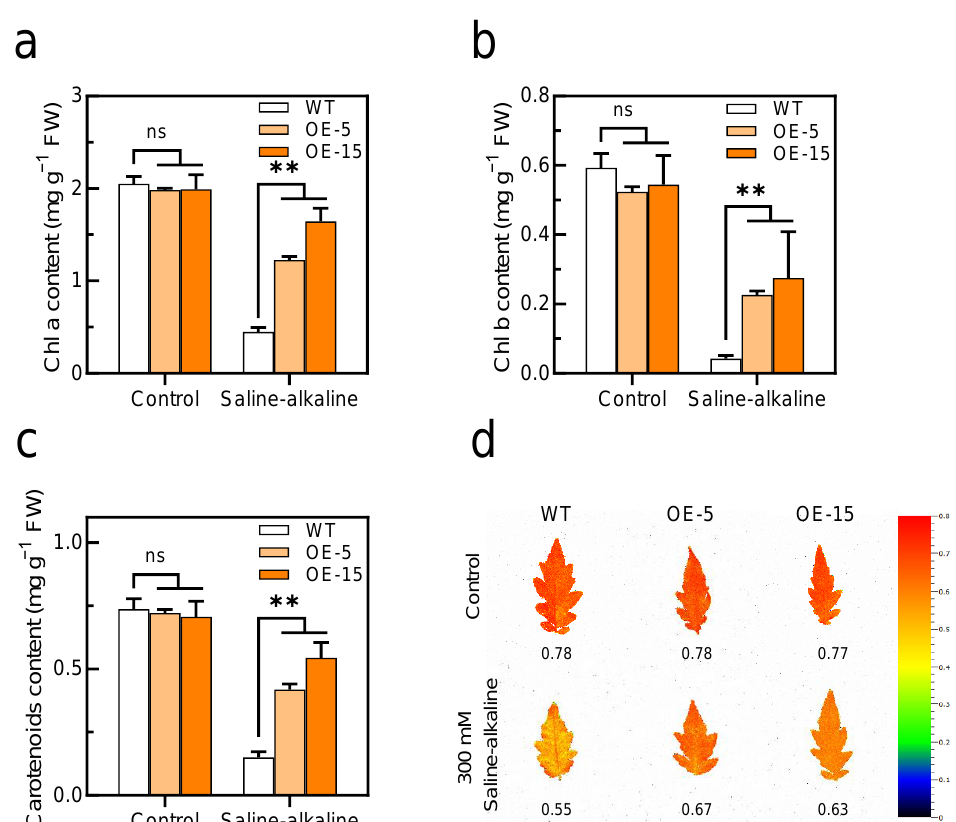
Figure 5. Overexpression of SlAREB1 confers enhanced photosynthetic capacity in transgenic toma- toes under saline–alkaline stress. ( a – c ) Chlorophyll a, chlorophyll b and carotenoids contents and ( d ) chlorophyll fluorescence ( Fv/Fm ) were measured in wild-type (WT) and transgenic (OE-5 and OE-15) tomato seedlings after 7 d of treatment with 300 mM saline–alkaline mixed solution. Distilled water was used as control. Values represent averages of four independent measurements, and error bars represent standard errors. Asterisks denote a significant difference compared with the control (** p < 0.01).